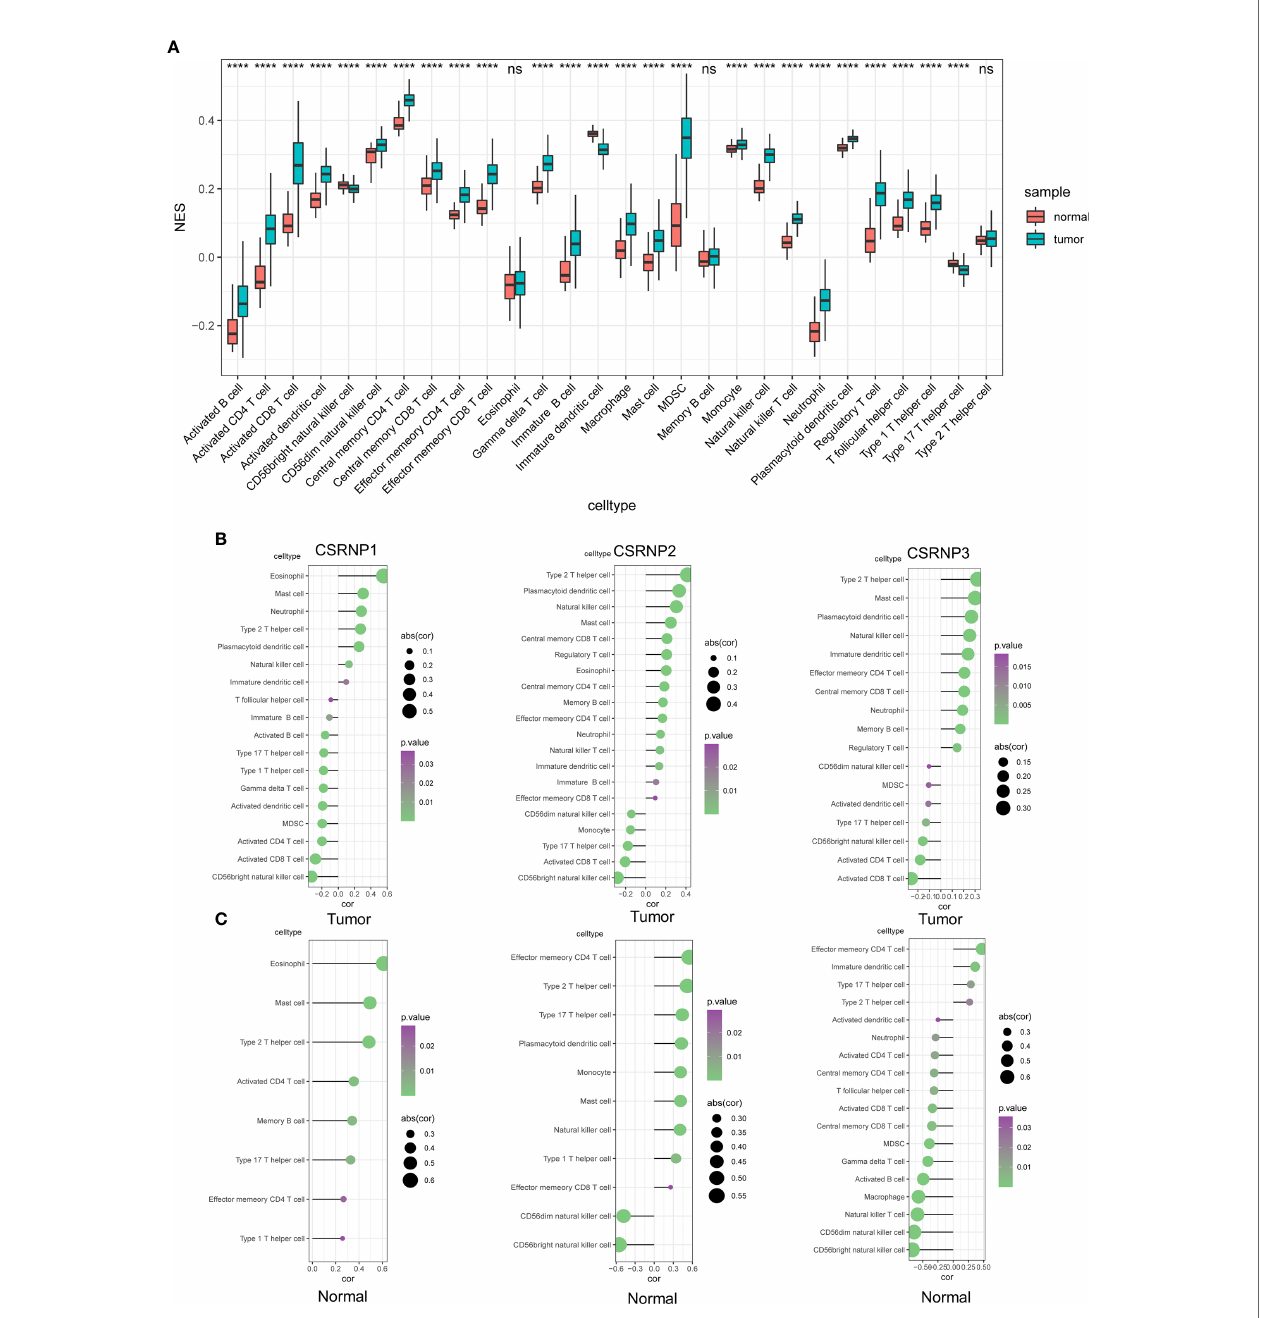
FIGURE 4 | Correlations between CSRNP family and immune in fi ltration. (A) Normalized enrichment scores (NES) of 28 immunocytes between normal and tumor tissues. (B, C) Correlations between CSRNP family and signi fi cant in fi ltrated immunocytes in tumor (B) and normal (C)